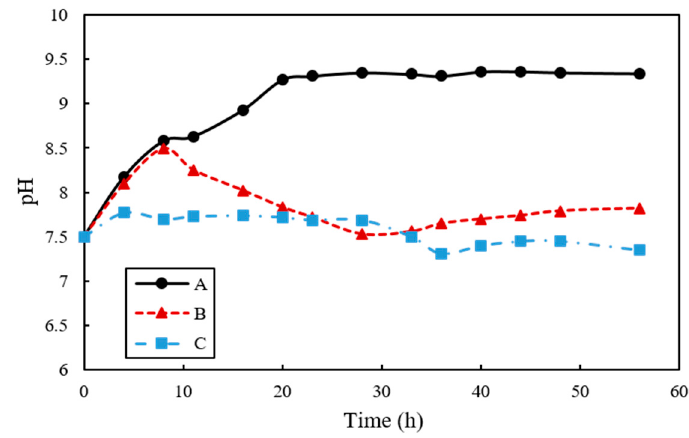
Figure 7. The changes of pH in urea–calcium lactate medium over time.